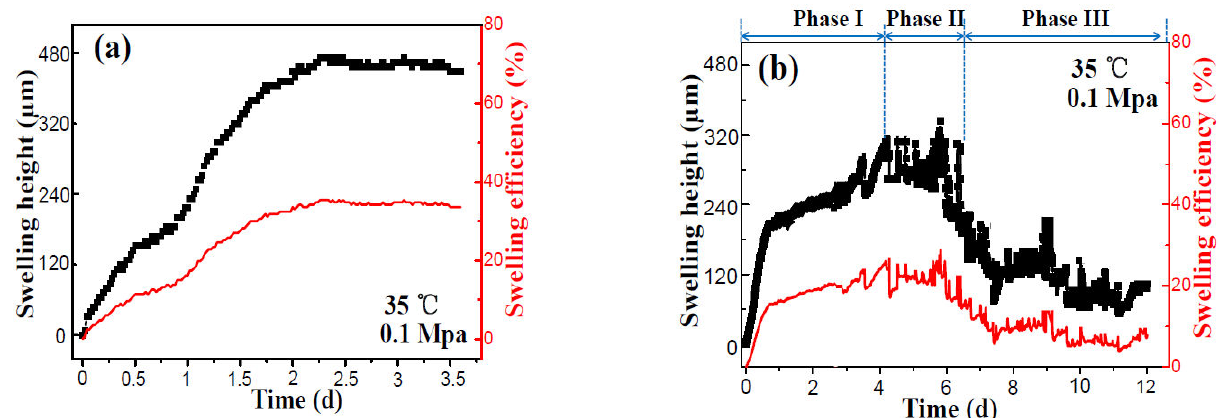
Figure 2. The hydro-swelling properties of the core plug with water flooding ( a ) and with FeRM flooding ( b